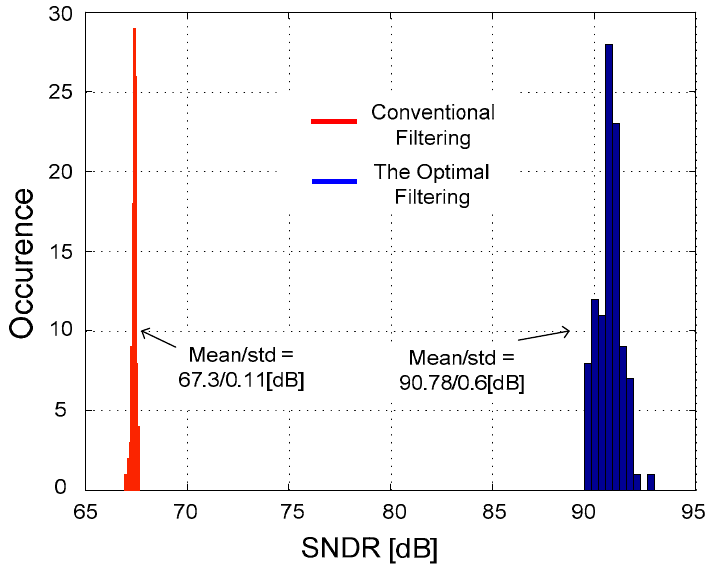
Figure 13. Histogram of the signal-to-noise and distortion ratio (SNDR) from 100 Monte-Carlo simulations.